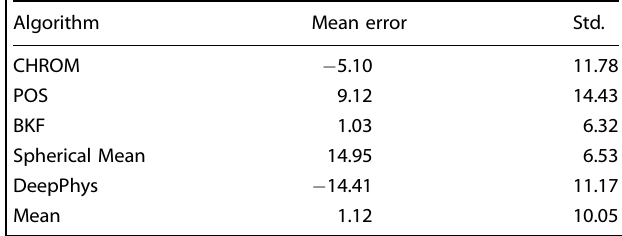
Table 5. Frequency of anomalies in outlier videos (each video can have more than one anomaly).